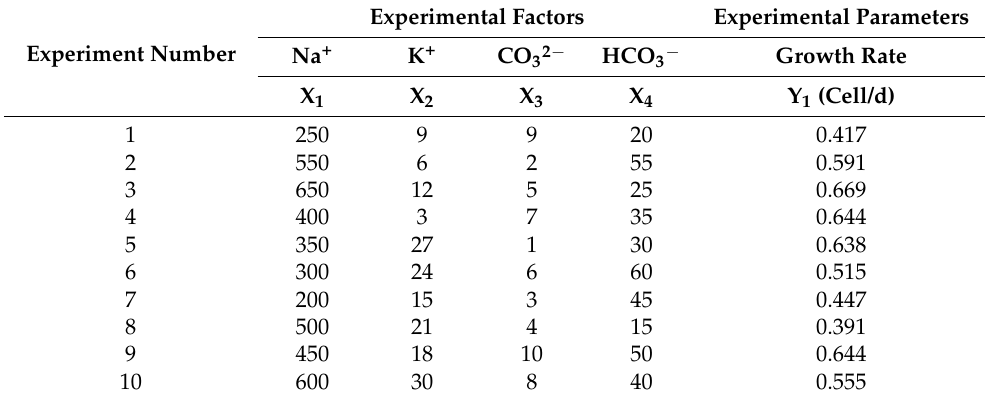
Table 4. Results of the growth rate of P. parvum under different concentrations of Na + , K + , CO 32 − , and HCO 3 − . Experimental Experiment Number